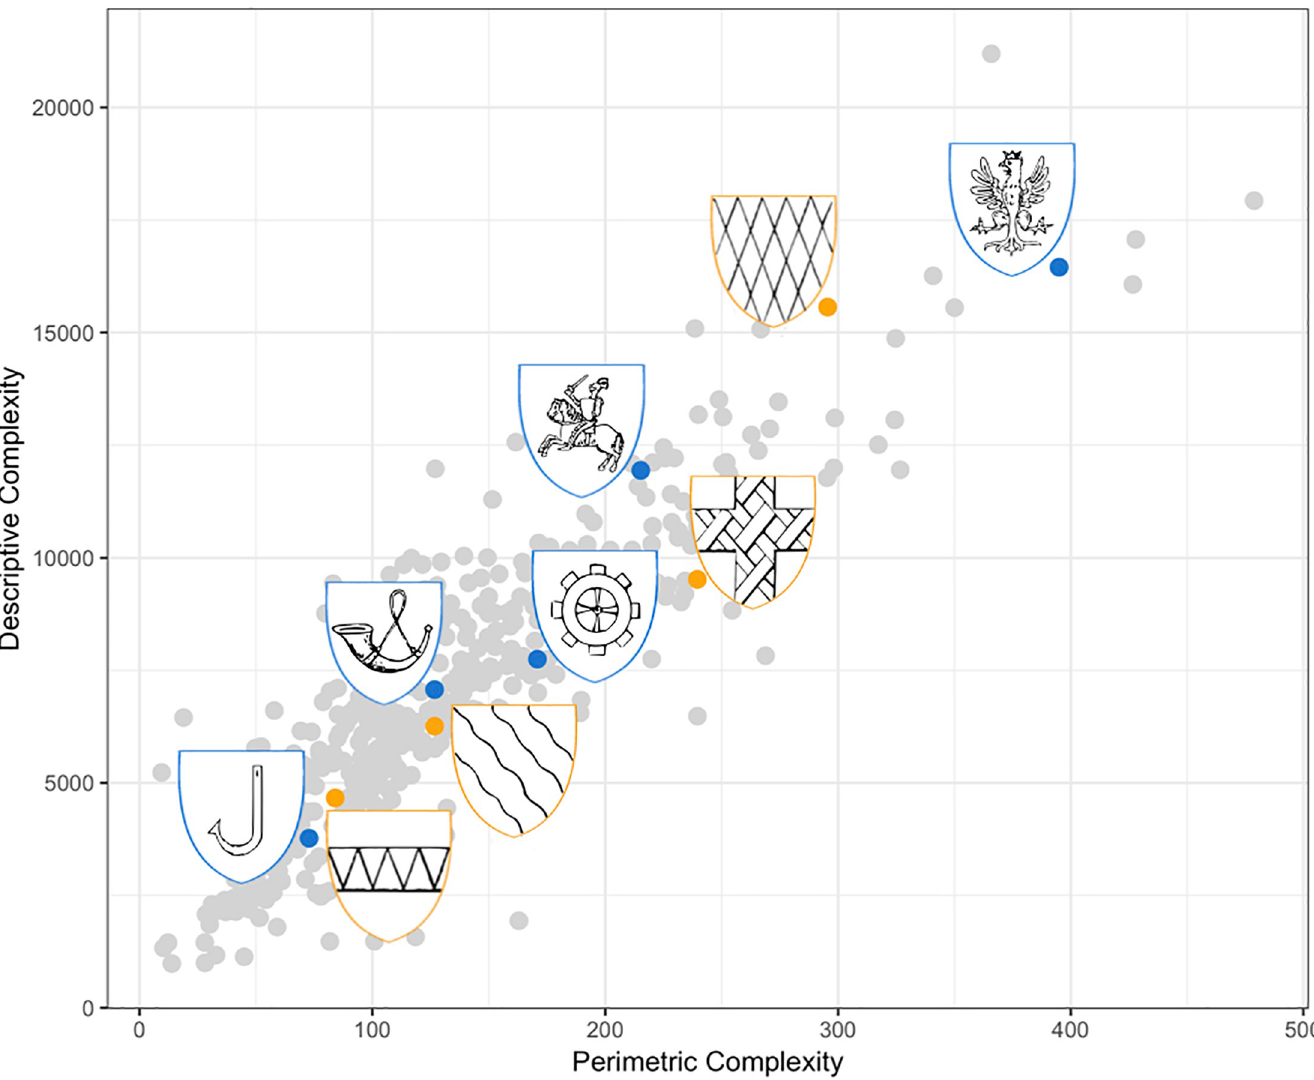
Fig 2. Relation between perimetric (x-axis) and descriptive (y-axis) complexity , with examples of iconic (blue frame) and non-iconic (yellow frame) motifs (total n = 447 motifs).